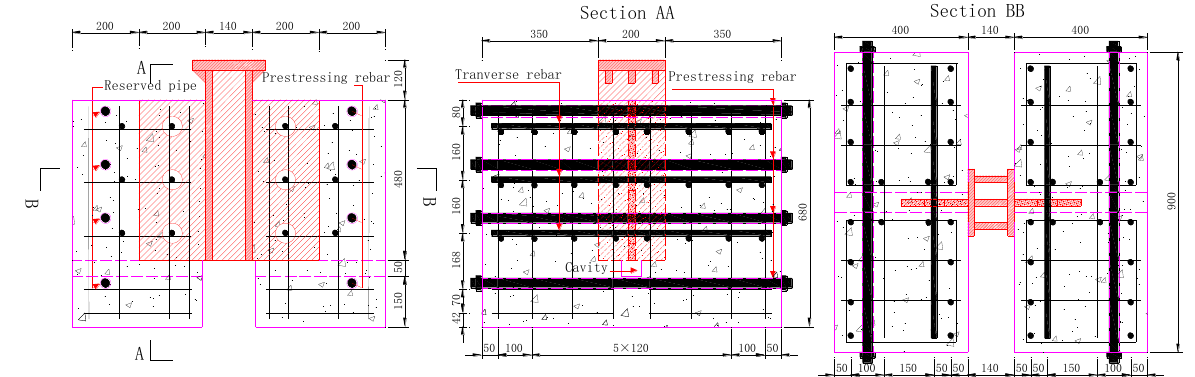
Figure 3. Dimensions of push-out specimens and perforated rib: BH-PP (unit: mm).